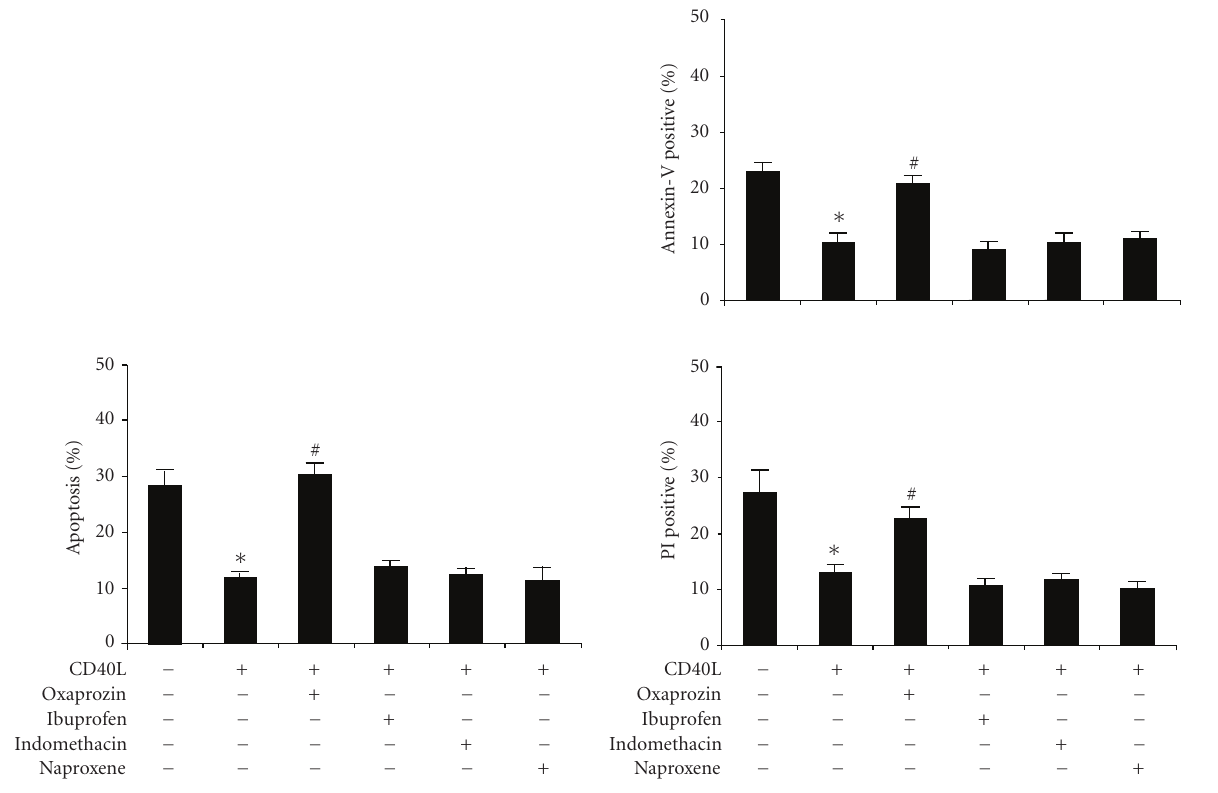
Figure 2: Oxaprozin-induced apoptosis is independent on COX inhibition . Monocytes were incubated for 48 hours with control medium or 200ng/mL CD40L plus 1 μ g/mL CD40L enhancer in the presence or absence of 100 μ M oxaprozin, 100 μ M ibuprofen, 100 μ M indomethacin, or 100 μ M naproxene. (a) Assessment of apoptosis by acridine-orange-stained slides under fluorescence microscopy. Data are express, as percentages of apoptotic cells on total number of cells counted (mean ± SEM, n = 4; apoptosis in absence versus in presence of CD40L: ∗ P < .05; apoptosis in presence of CD40L versus CD40L plus oxaprozin: # P < .05; apoptosis in presence of CD40L versus CD40L plus other NSAIDs: N.S.). (b) Assessment of apoptosis by using Annexin V and Propidium Iodide (PI) binding assay (mean ± SEM, n = 3; apoptosis in absence versus in presence of CD40L: ∗ P < .05; apoptosis in presence of CD40L versus CD40L plus oxaprozin: # P < .05; apoptosis in presence of CD40L versus CD40L plus other NSAIDs: